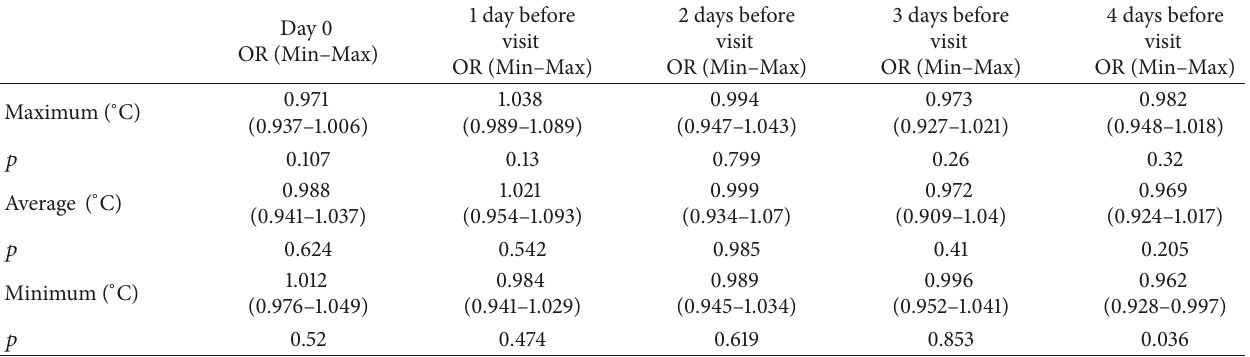
Table 6: Temperature for 4 days before visit due to pneumonia.